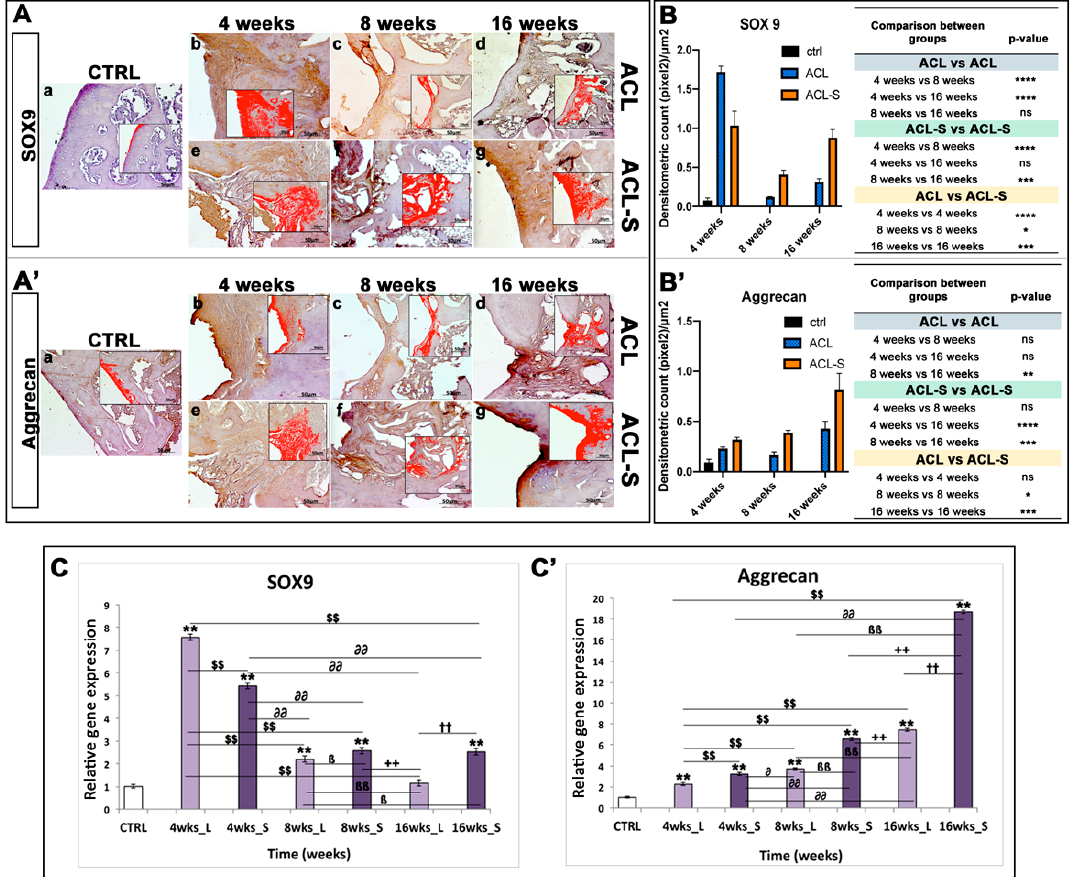
Figure 4. Sox9 and aggrecan evaluation in femoral articular cartilage samples at 4-, 8- and 16-weeks post-surgery. ( A–A’ ) Immunohistochemical analyses: ( a ) control sample of articular cartilage; ( b–d ) ACL group samples at 4-, 8- and 16-weeks; ( e–g ) ACL-S group samples at 4-, 8- and 16-weeks. In the inserts, the red colour corresponds to brown staining (immune complexes labelled with chromogen); scale bars 50 µ m. ( B–B’ ) Graph representing staining level expressed as densitometric count (pixel 2 ) normalized to the area of each section expressed in µ m 2 . ( C–C’ ) Relative quantitation (RQ) of gene expression showing the time-course of Sox9 and Aggrecan in ACL (L) and ACL-S (S) groups, after 4-, 8-, and 16-weeks from surgery. TUBB4a has been used as endogenous controls. Results are presented as the mean ± SD. Differences between groups were evaluated by using a two-way ANOVA followed by Tukey’s multiple comparison post-hoc test (* p < 0.05; ** p < 0.01; *** p < 0.001; **** p < 0.0001; ns, not significant). * CTRL vs 4-, 8-, 16- wks_L and 4-, 8-, 16-wks_S; $ 4-wks_L vs 8-, 16-wks_L and 4-, 8-, 16-wks_S; ∂ 4-wks_S vs 8-, 16-wks_L and 8-, 16-wks_S; β 8-wks_L vs 16-wks_L and 8-, 16-wks_S; + 8-wks_S vs 16-wks_L and 16-wks_S; † 16-wks_L vs 16-wks_S.